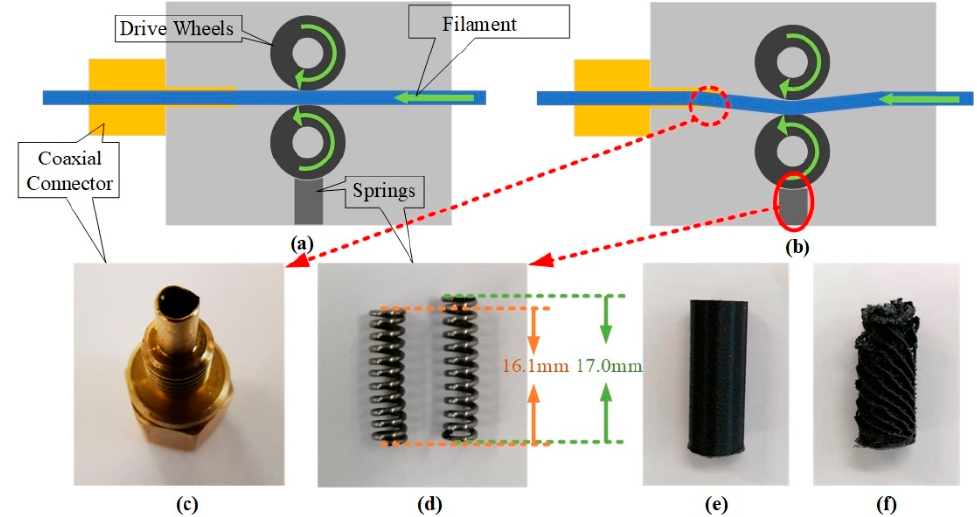
Figure 3. The failure mechanism of the filament jam: ( a ) the normal state; ( b ) the filament jam state caused by the increasing friction force between the filament and the coaxial connector; ( c ) the worn coaxial connector; ( d ) the fatigued spring (16.1 mm) and the normal spring (17.0 mm); ( e ) the normal specimen; ( f ) the specimen built in the filament jam state.